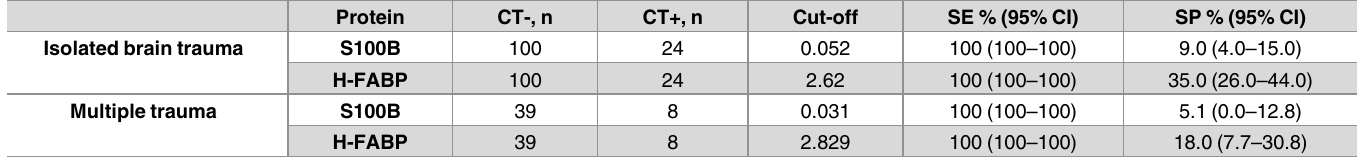
This multicentre study evaluated H-FABP and S100B as potential protein biomarkers for dif- ferentiating between CT-positive and CT-negative mTBI patients with GCS scores of 15 and at least one clinical symptom. H-FABP reached 100% sensitivity and 29% specificity, whereas S100B reached 100% sensitivity but only 6% specificity. The proteins’ performances were fur- ther investigated when sensitivity was set in the 90%–100% range. Here, S100B reached a specificity of 19% with a sensitivity of 91%. However, H-FABP performed better, with 100% sensitivity and 29% specificity. Table 5. The performances of H-FABP and S100B biomarkers at 100% sensitivity, (cid:20) 6 h post-trauma in mTBI subgroups; isolated brain trauma or multiple trauma patients. Protein CT-,